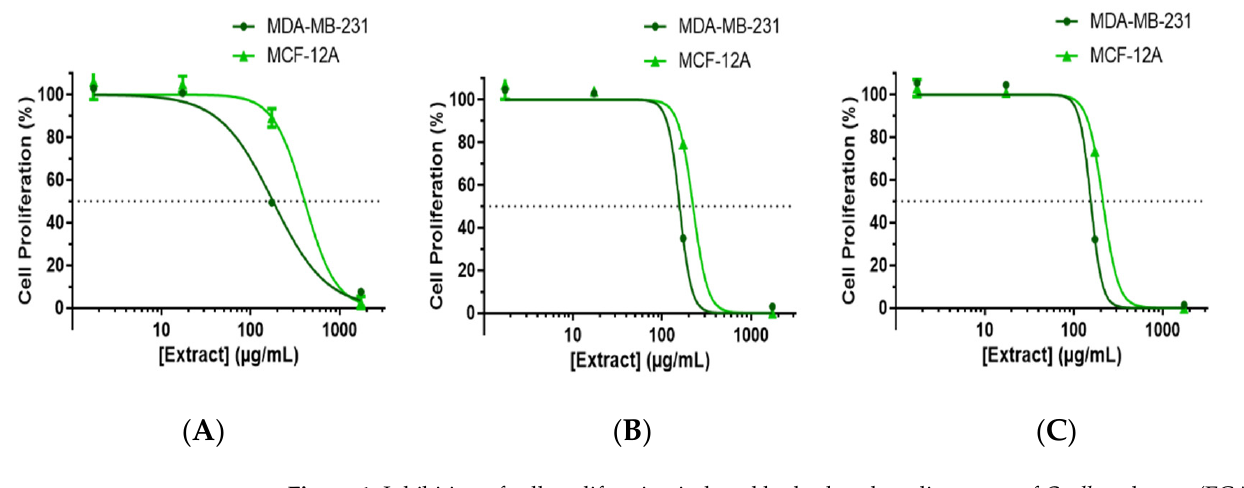
Figure 1. Inhibition of cell proliferation induced by hydroethanolic extract of C. album leaves (ECAL) in MDA-MB-231 and MCF-12A cells. Cells were treated with increasing concentrations of ECAL (1.7–1730 µ g/mL) for ( A ) 24 h, ( B ) 48 h and ( C ) 72 h. Label-free kinetic live monitoring of cell proliferation was performed using a LionheartFX automated microscope with the direct image acquisition of cells in microplates at 0, 24, 48 and 72 h of the post-addition of the tested